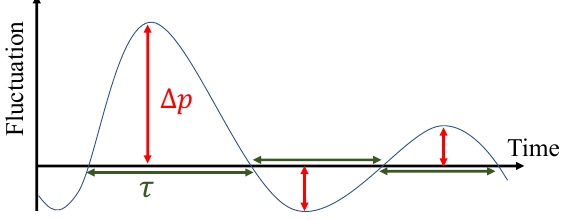
Figure 6. Amplitude, ∆ p , and half-cycle period, τ , of short-term fluctuations. The distributions of ∆ p and τ in the three BAs are shown in Figure 7. The τ values involving the maximum ∆ p in each BA occur at approximately 15 min. Thus, the cycle period that could have the maximum impact on power systems is approximately 30 min. The maximum ∆ p values in the Hokkaido area tended to be the largest ones among the three BAs. Conversely, the ∆ p values in the Kyushu area were relatively